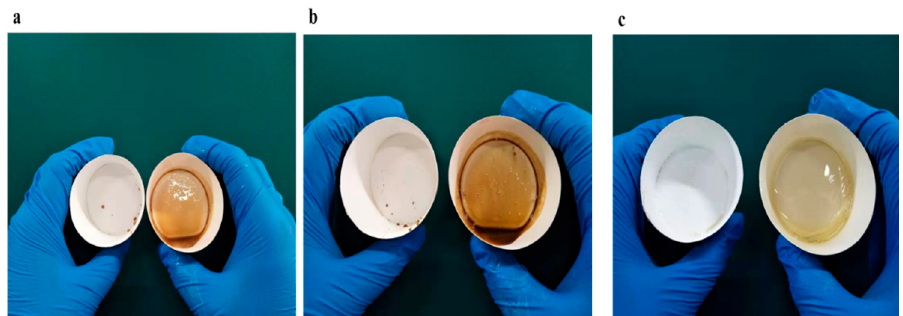
Figure 12. Photographs of (left) remaining viscous liquid after pouring in a soybean wax coated cup and (right) original cup: ( a ) milky tea; ( b ) chocolate syrup and ( c ) honey.